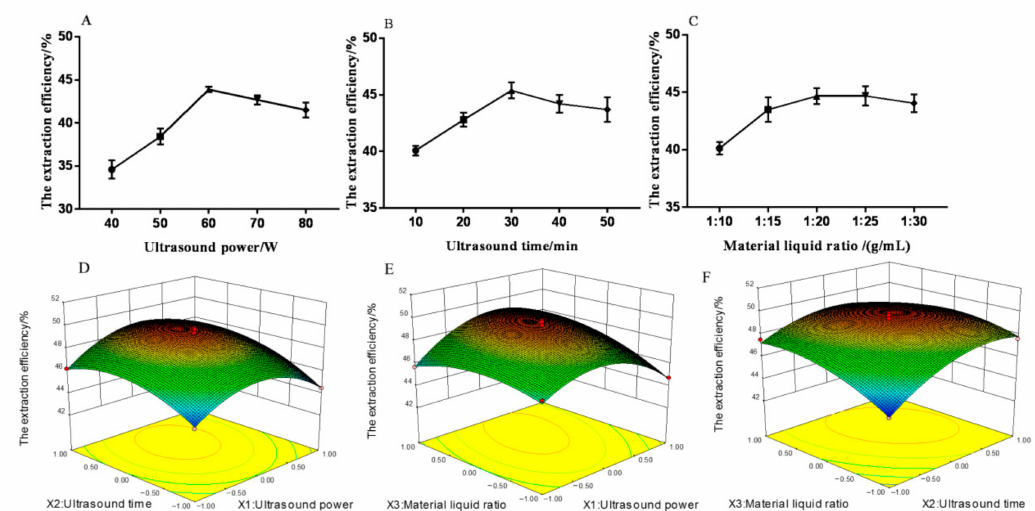
Figure 2. Effect of ultrasonic power ( A ), ultrasonic time ( B ), material–liquid ratio ( C ), ultrasonic power and ultrasonic time ( D ), ultrasonic power and material–liquid ratio ( E ), ultrasonic time and material–liquid ratio ( F ) on the extraction efficiency of polysaccharides from Malus hupehensis .